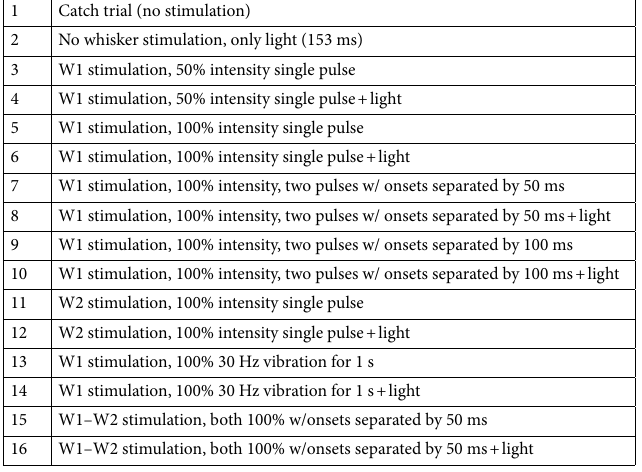
Table 1. Overview over stimuli (W1: (principal) whisker 1, W2: whisker